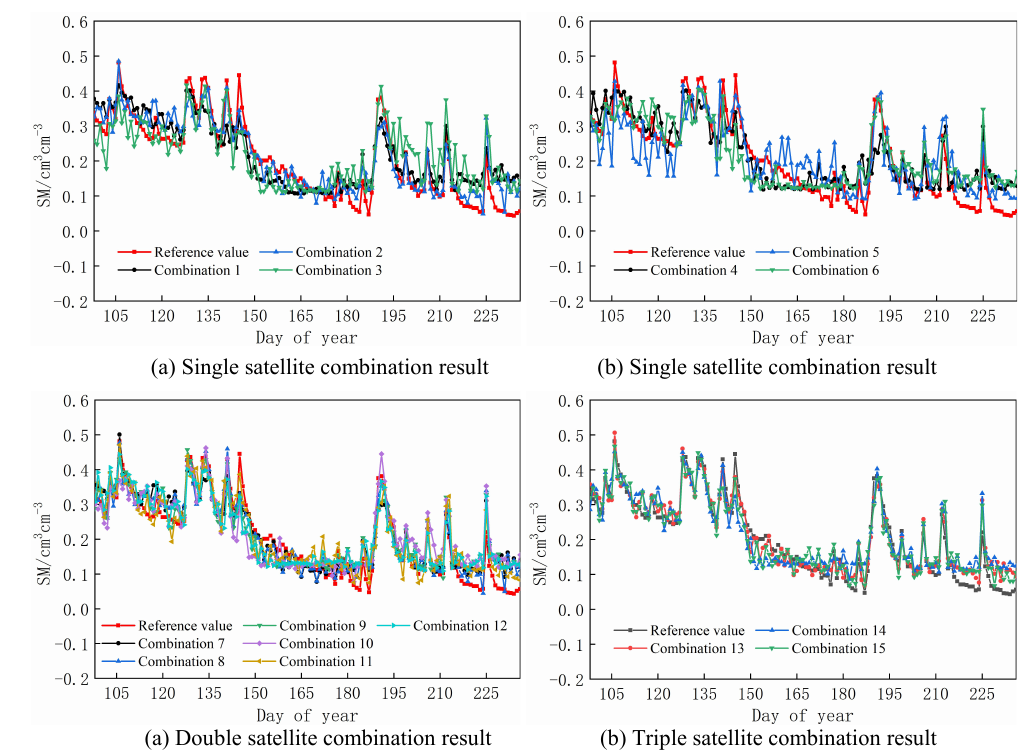
Tab. 3 Triple star nonlinear regression model regression coefficient